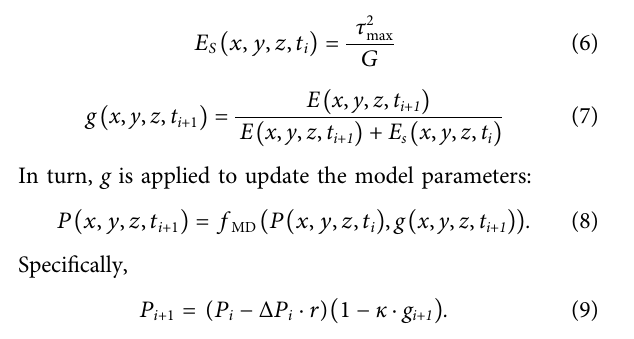
Frontiers in Earth Science |